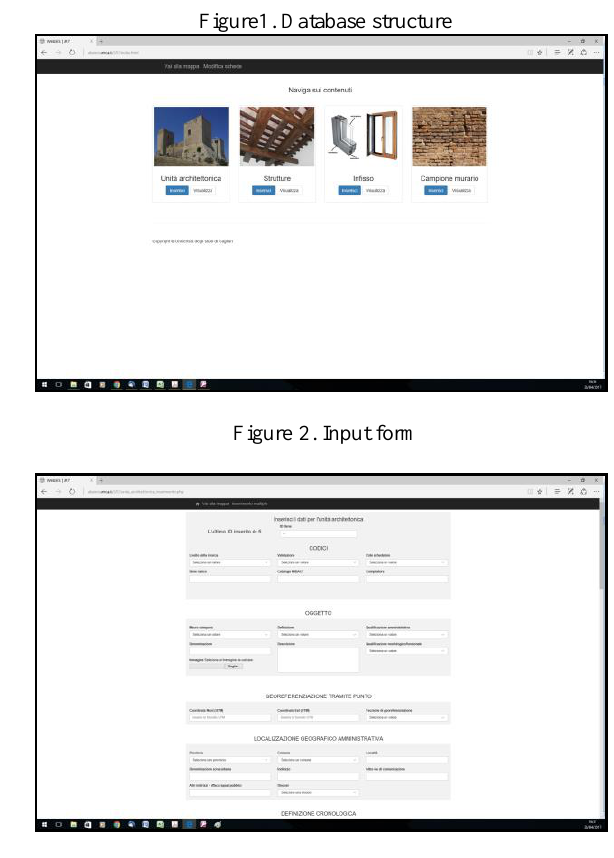
Figure 3. Unità architettonica input form